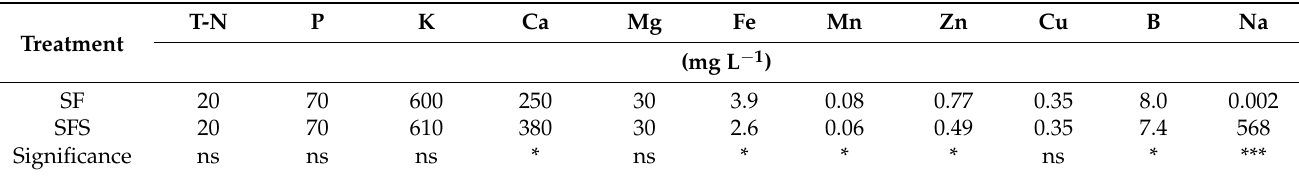
Figure 1. Weekly pH (Panel ( A )) and EC (Panel ( B )) in starfish (SF)- and starfish + seaweed (SFS)- liquid fertilizers at weeks of storage. Table 1. Nutrient concentrations in liquid fertilizers with starfish (SF)- and starfish + seaweed (SFS) resources used in an experimental